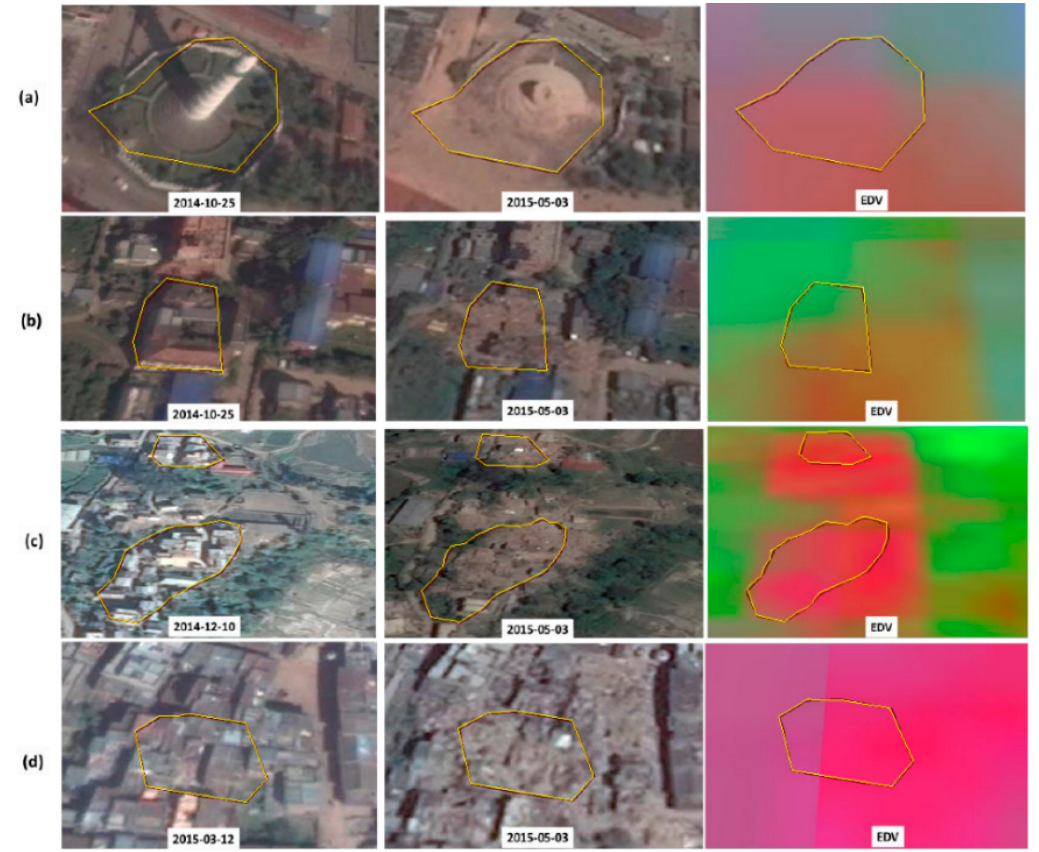
Figure 6. Performance of the EDV in different locations ( a – d ) that were highly damaged by the earthquake. The blocks of highly damaged (lethal) buildings are delineated by yellow polygons in each image. The left and middle columns show pre-seismic and post-seismic Google Earth images, whereas the right column shows the EDV image. The date of the Google Earth image is labeled in each image. The amount of redness in the EDV indicates severity of the building damage.